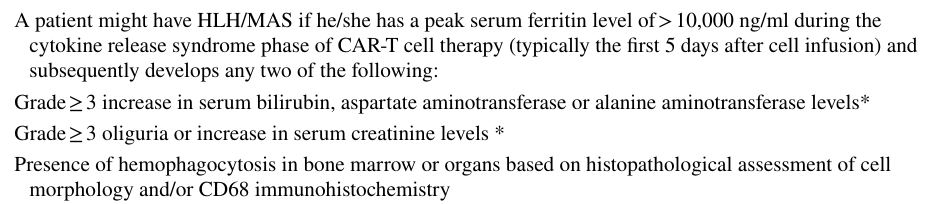
criteria for CAR-T cell related HLH/MAS: